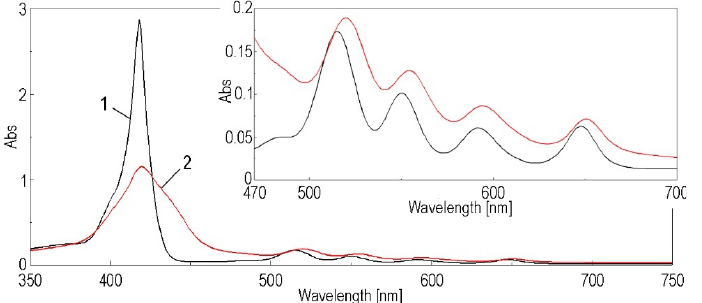
Figure 3. Overlapped UV-Vis spectra for the (5-COOH-3MPP)-k-carrageenan composite gel diluted with only DMF (1) and with DMF: water = 2:3 ( v/v ) mixture (2).